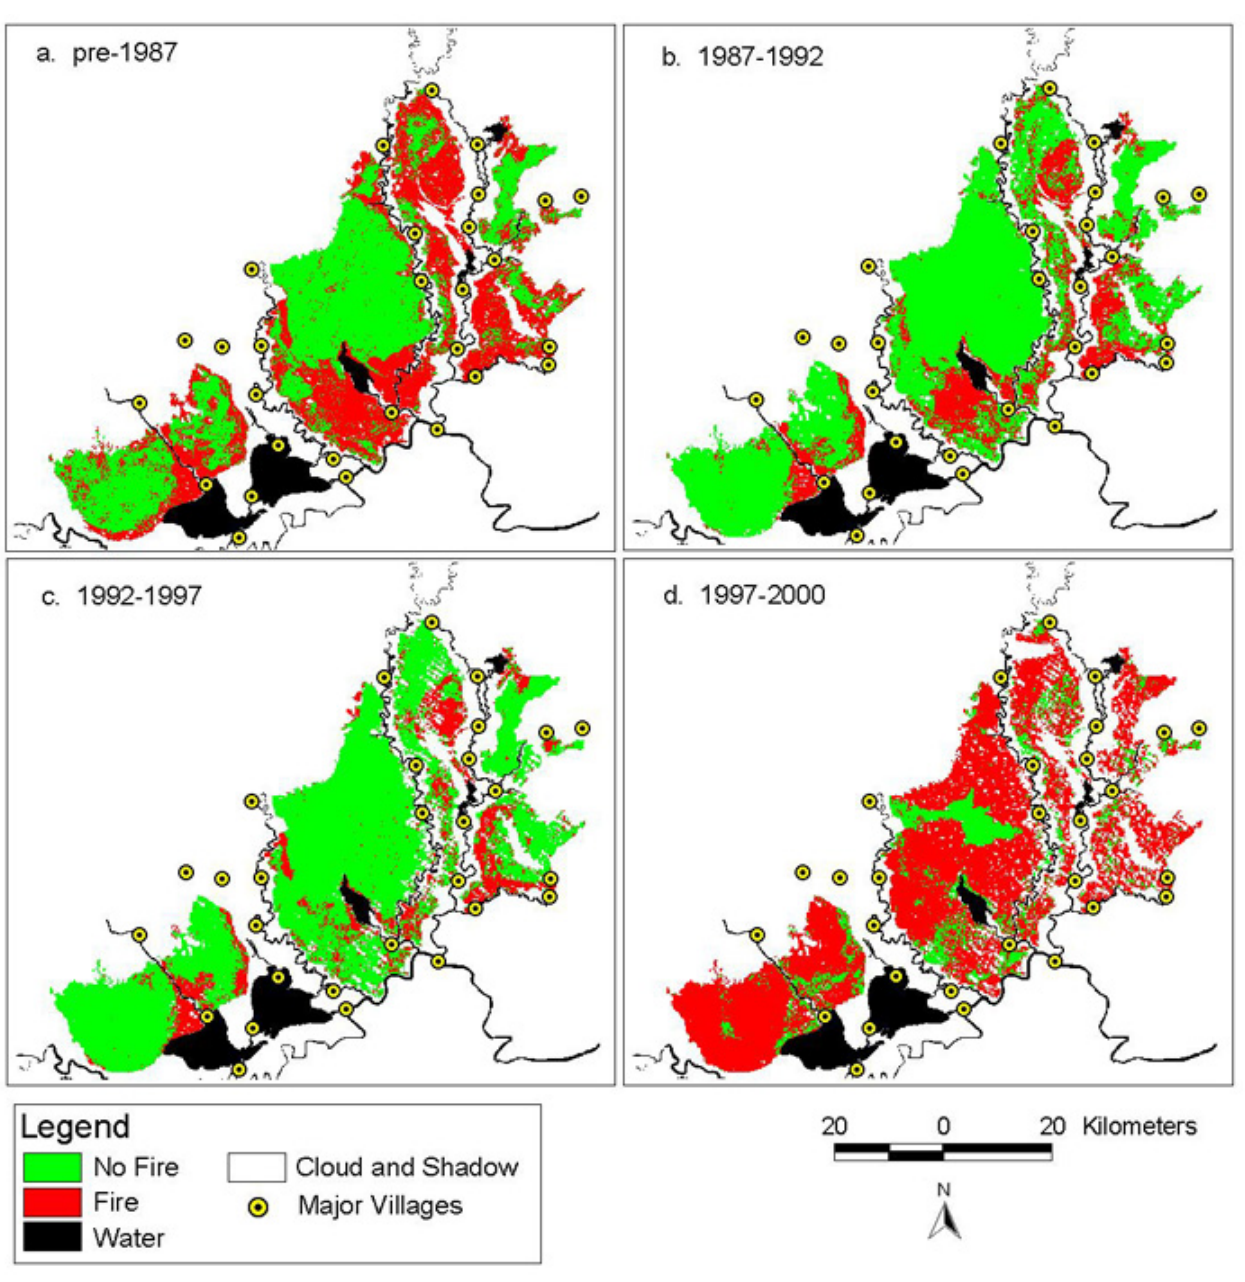
Fig. 3. Area affected by fire (conservative estimate) before 1987; and between 1987–1992, 1992–1997, and 1997–2000 in the Middle Mahakam study